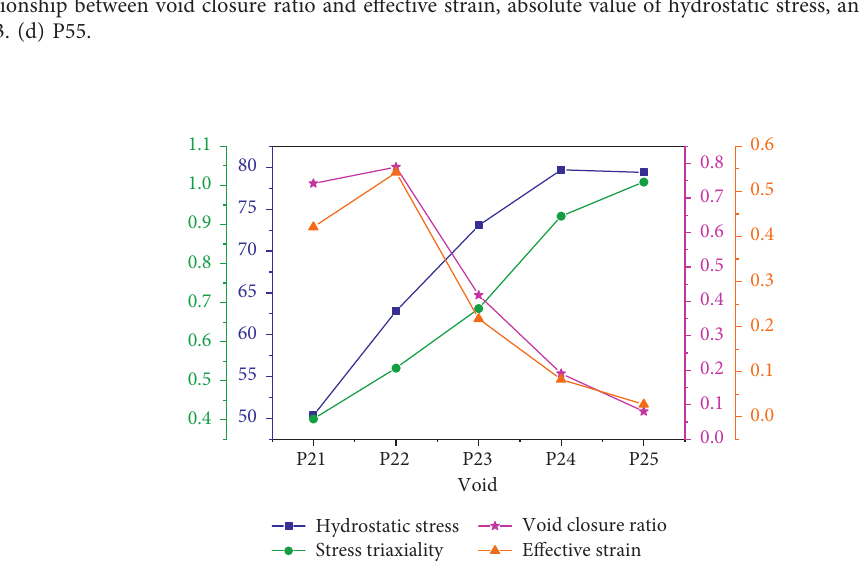
Figure 4: Relationship between void closure ratio of P21–P25 voids and effective strain, absolute value of hydrostatic stress, and stress triaxiality at 30%